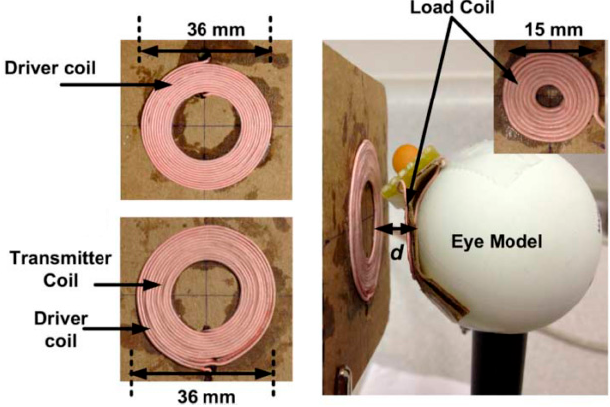
Figure 25. Eye model for three-coil WPT performance evaluation [146]. Copyright © 2012, IEEE.